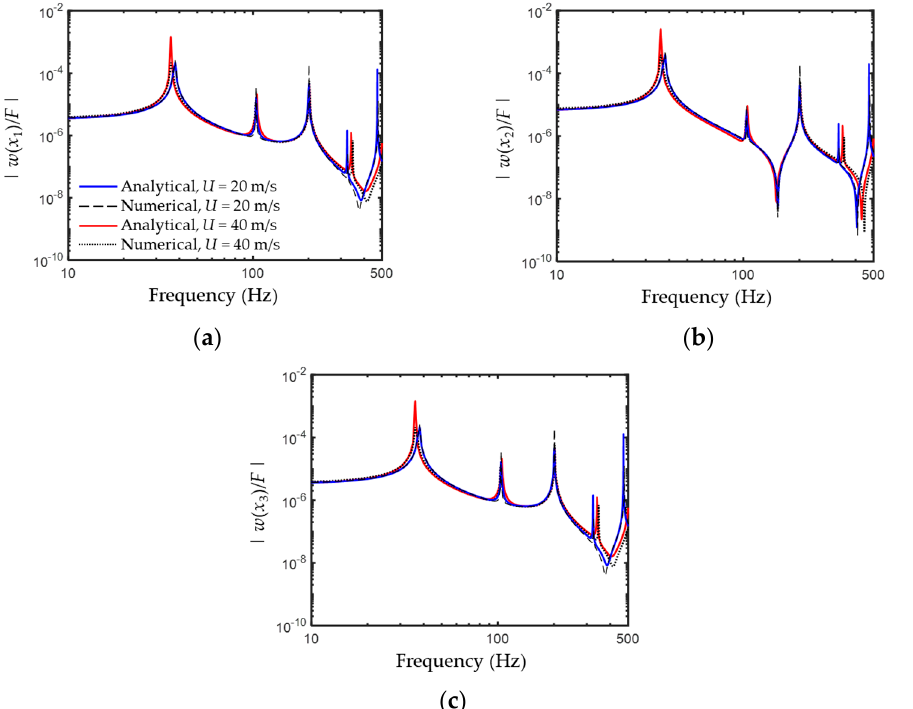
Figure 8. Analytical vs. numerical transfer functions of the fluid-conveying pipes at ( a ) x = x 1 , ( b ) x 2 , and ( c ) x 3 .